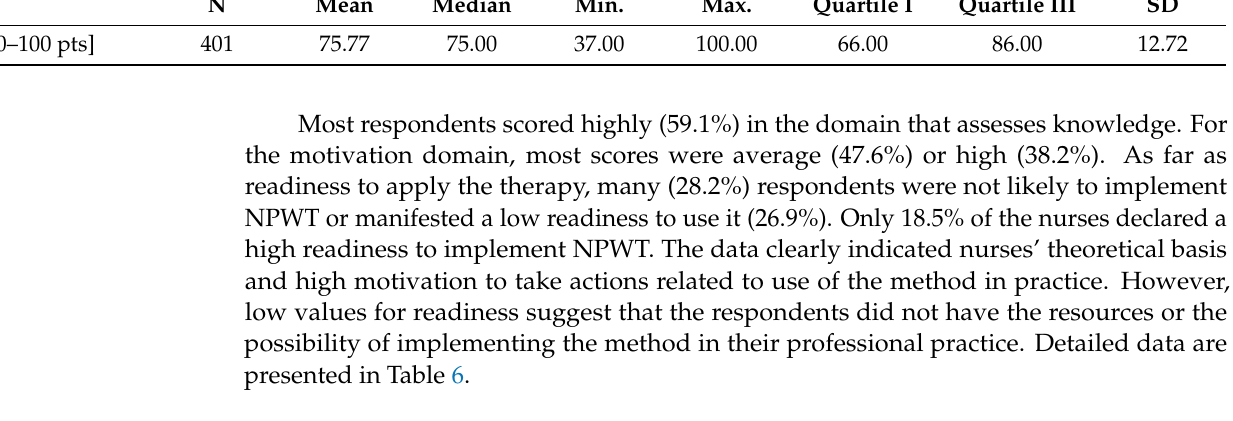
Table 6. The results of the NPWT perception questionnaire ( n =